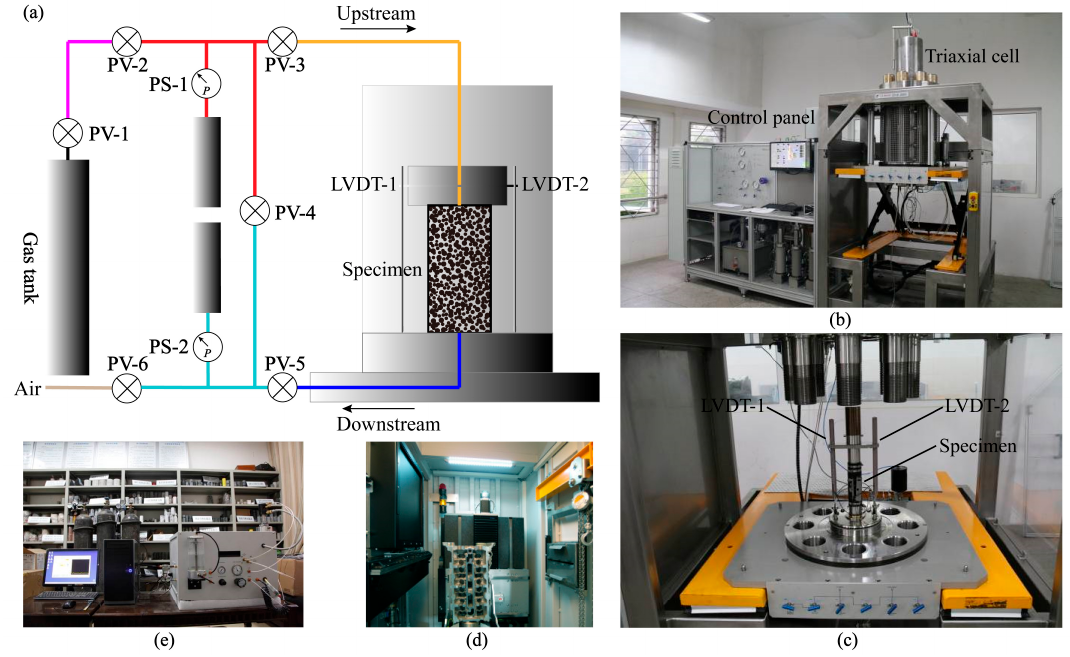
Figure 4. Experimental testing equipment. ( a ) Schematic diagram of the testing system. ( b ) Hydromechanical coupling testing machine. ( c ) Rock specimen installation. ( d ) X-ray microfocus Computed Tomography (CT)